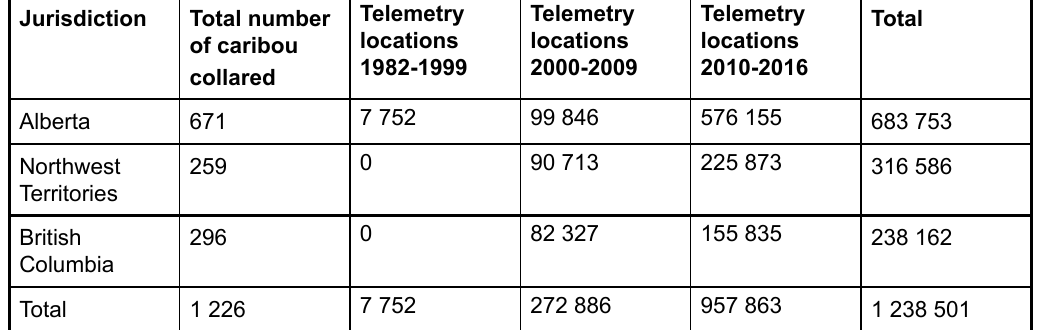
Table 1. Distribution among jurisdictions and sample size of telemetry